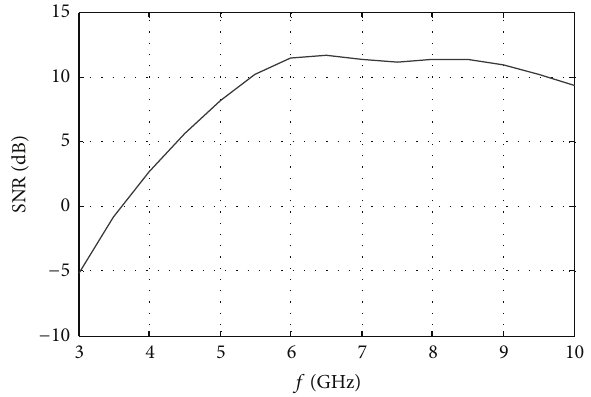
Figure 7: Variation of the numerical SNR versus frequency in the